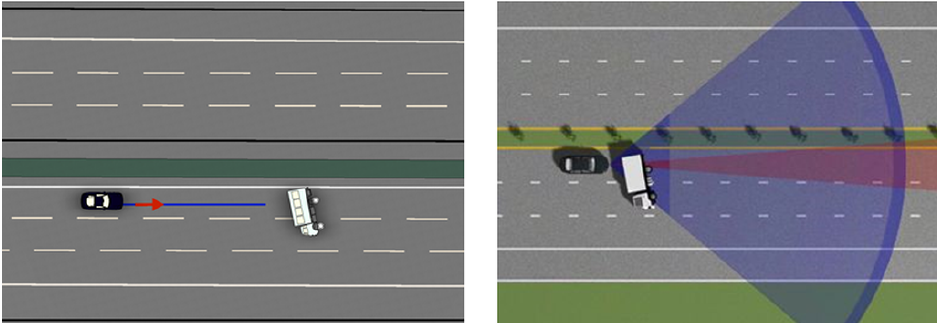
Figure 3. Top view about the second scenario when Tesla crashed into an overturned truck; reconstruct with two